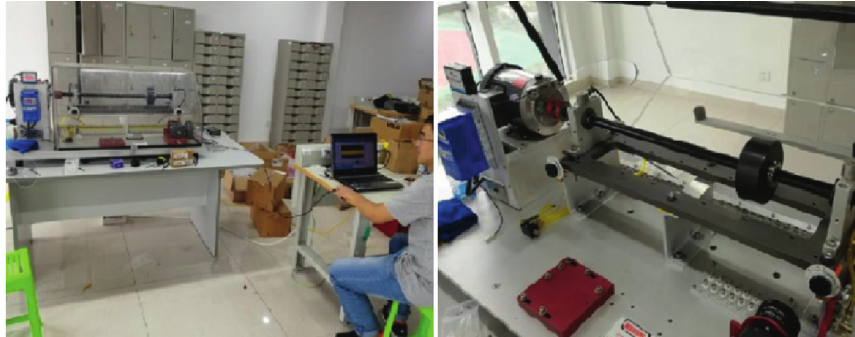
Figure 5: SQI-MFS test platform.